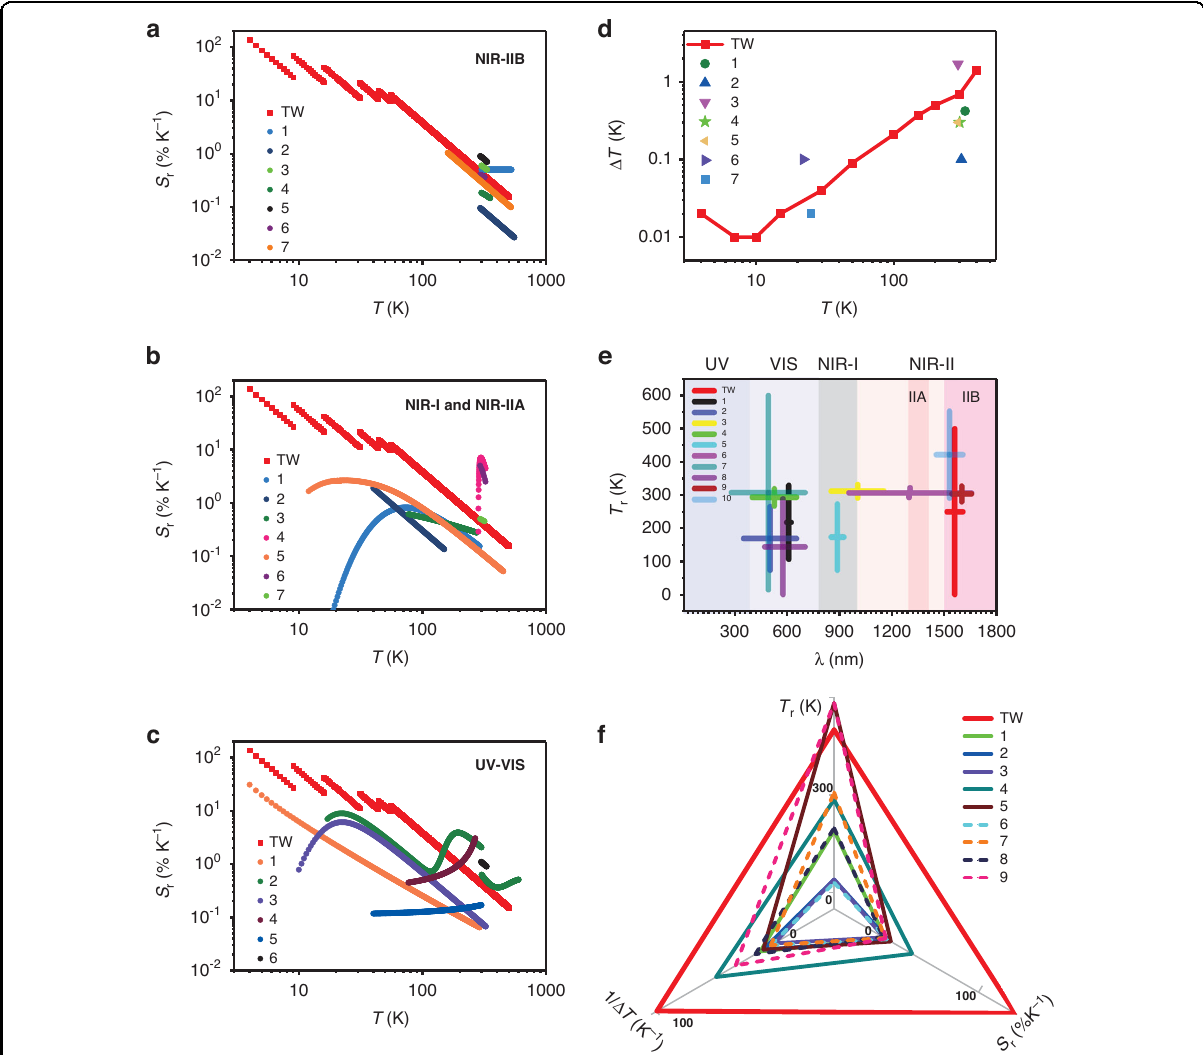
Fig. 3 Comparisons of key performance characteristics of this paper with Existing Approaches (TW: this work). a – c Comparison of relative sensitivities of our approach with available best data in literature working in the pure NIR-IIB, UV – VIS, and NIR-I/NIR-IIA band, respectively. a 1 – 7 represent refs. 54,71,75 – 79 , respectively. b 1 – 7 represents refs. 12,44,47,58,60,80,81 , respectively. c 1 – 6 represents refs. 25,30 – 33,51 , respectively. d Comparison of temperature resolutions with literature (1 – 7 represent refs. 5,12,28,31,44,47,51 , respectively). e Comparison of sensible temperature ranges vs. wavelengths (1 – 10 represent refs. 5,28,30,33,43,47,51,54,58,76 , respectively), where the length of the vertical bars represent the temperature ranges of various sensing approaches while the width of the horizontal bars represents the range of wavelengths used. f A summary comparison of key characteristics with literature (1 – 9 represent refs. 12,30,33,47,51,56,58,71,72 ,